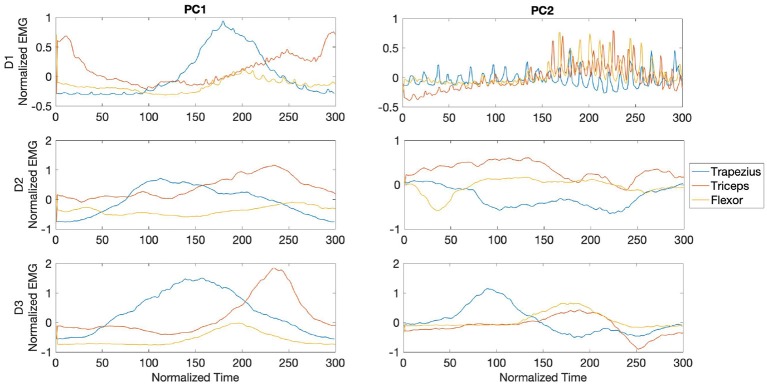
Waveforms showing the two principal components of muscle activation across the trapezius (blue), triceps (orange), and wrist flexor (yellow) muscles for drummers D1-3 in the fast phase (top right panel in Figure 7). Each panel shows the activation pattern centered around stroke onset (150 ms). The difference in activation patterns across players is clearly seen.